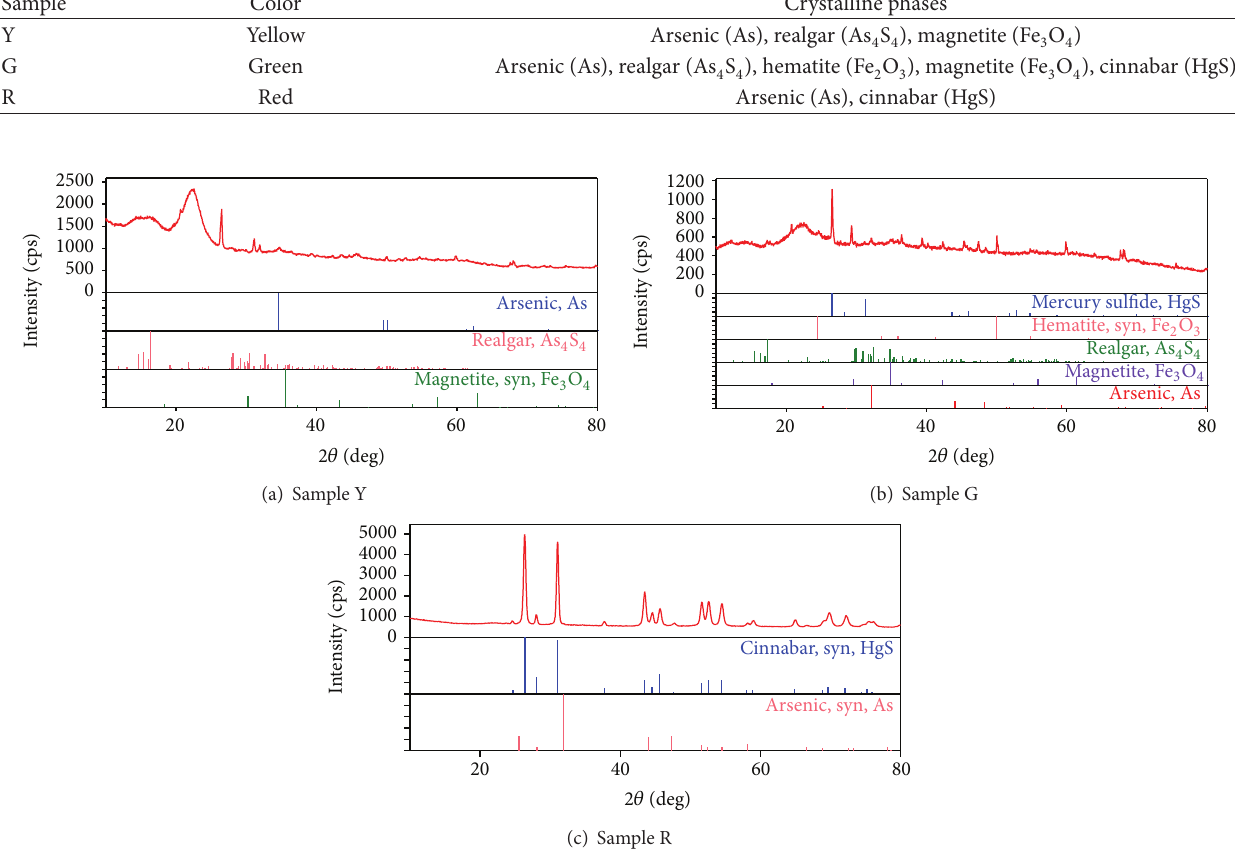
Figure 3: XRD crystal diffraction